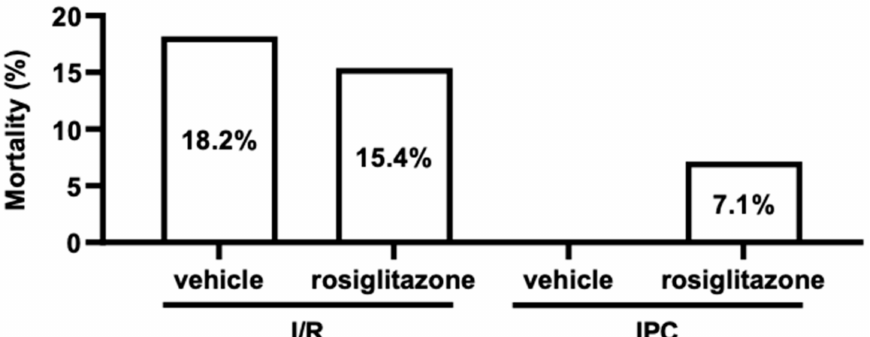
Figure 4. Mortality. Chronic rosiglitazone treatment does not influence mortality during is- chemia/reperfusion injury, nor does it affect mortality in connection with ischemic preconditioning. (Percentage; chi-square test, n = 11–14). IPC : ischemic preconditioning; I/R : ischemia/reperfusion.